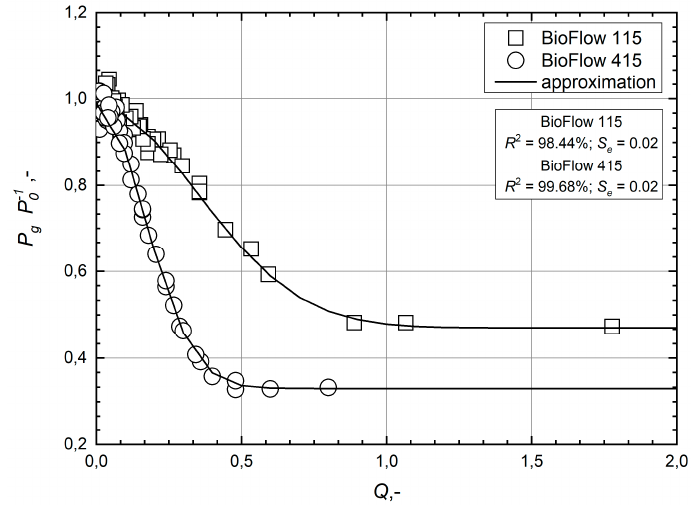
Figure 5. Experimental (symbols) and fitted (lines) relative power consumption values obtained for the tested bioreactors.